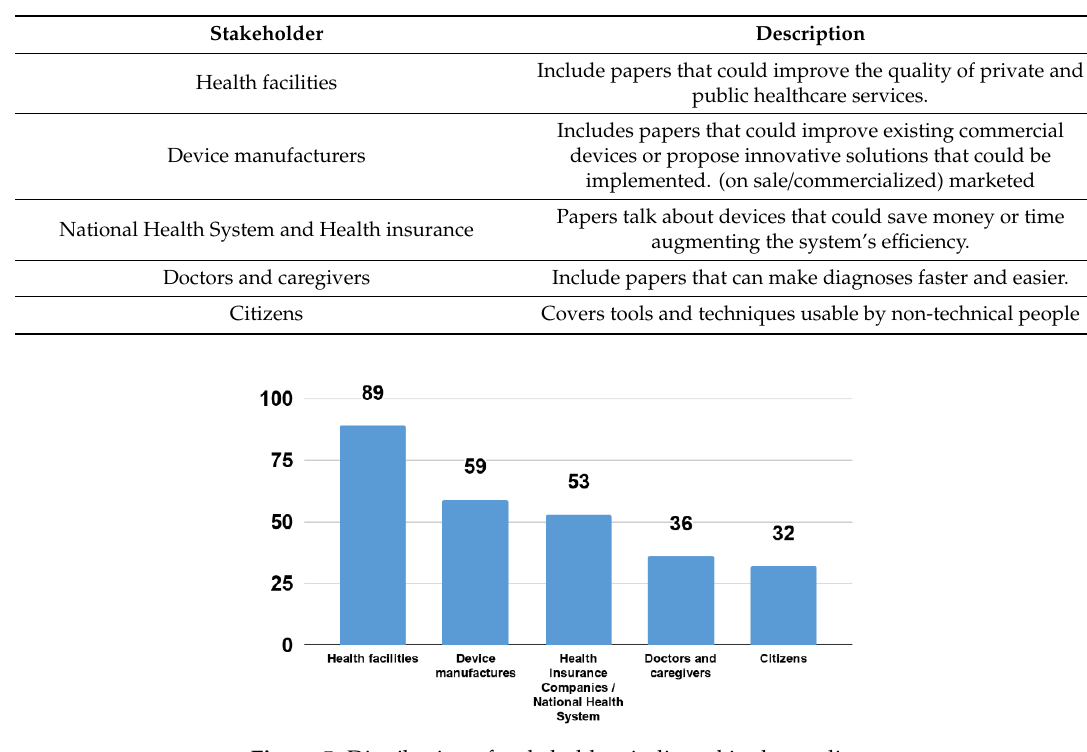
Figure 5. Distribution of stakeholders indicated in the studies.